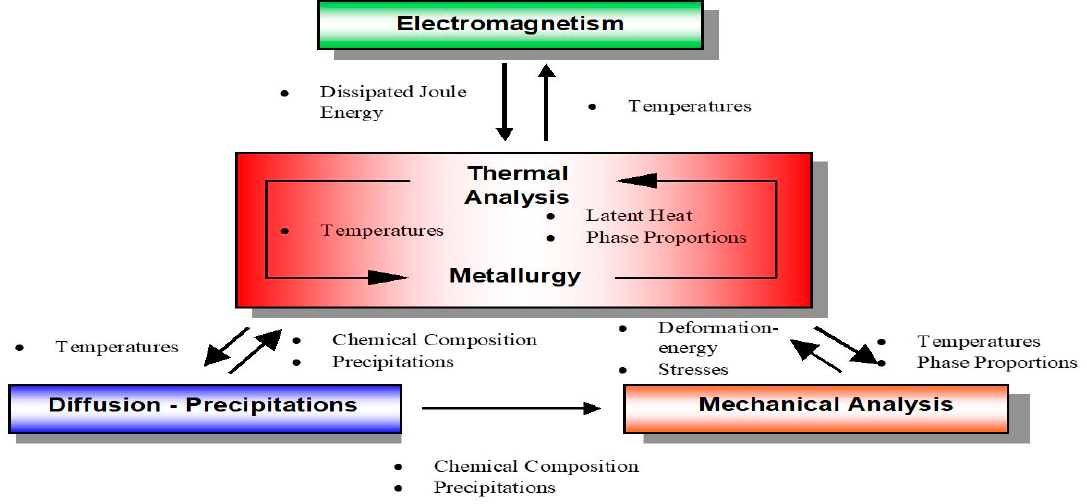
Figure 1. Interrelated physical phenomena [6].